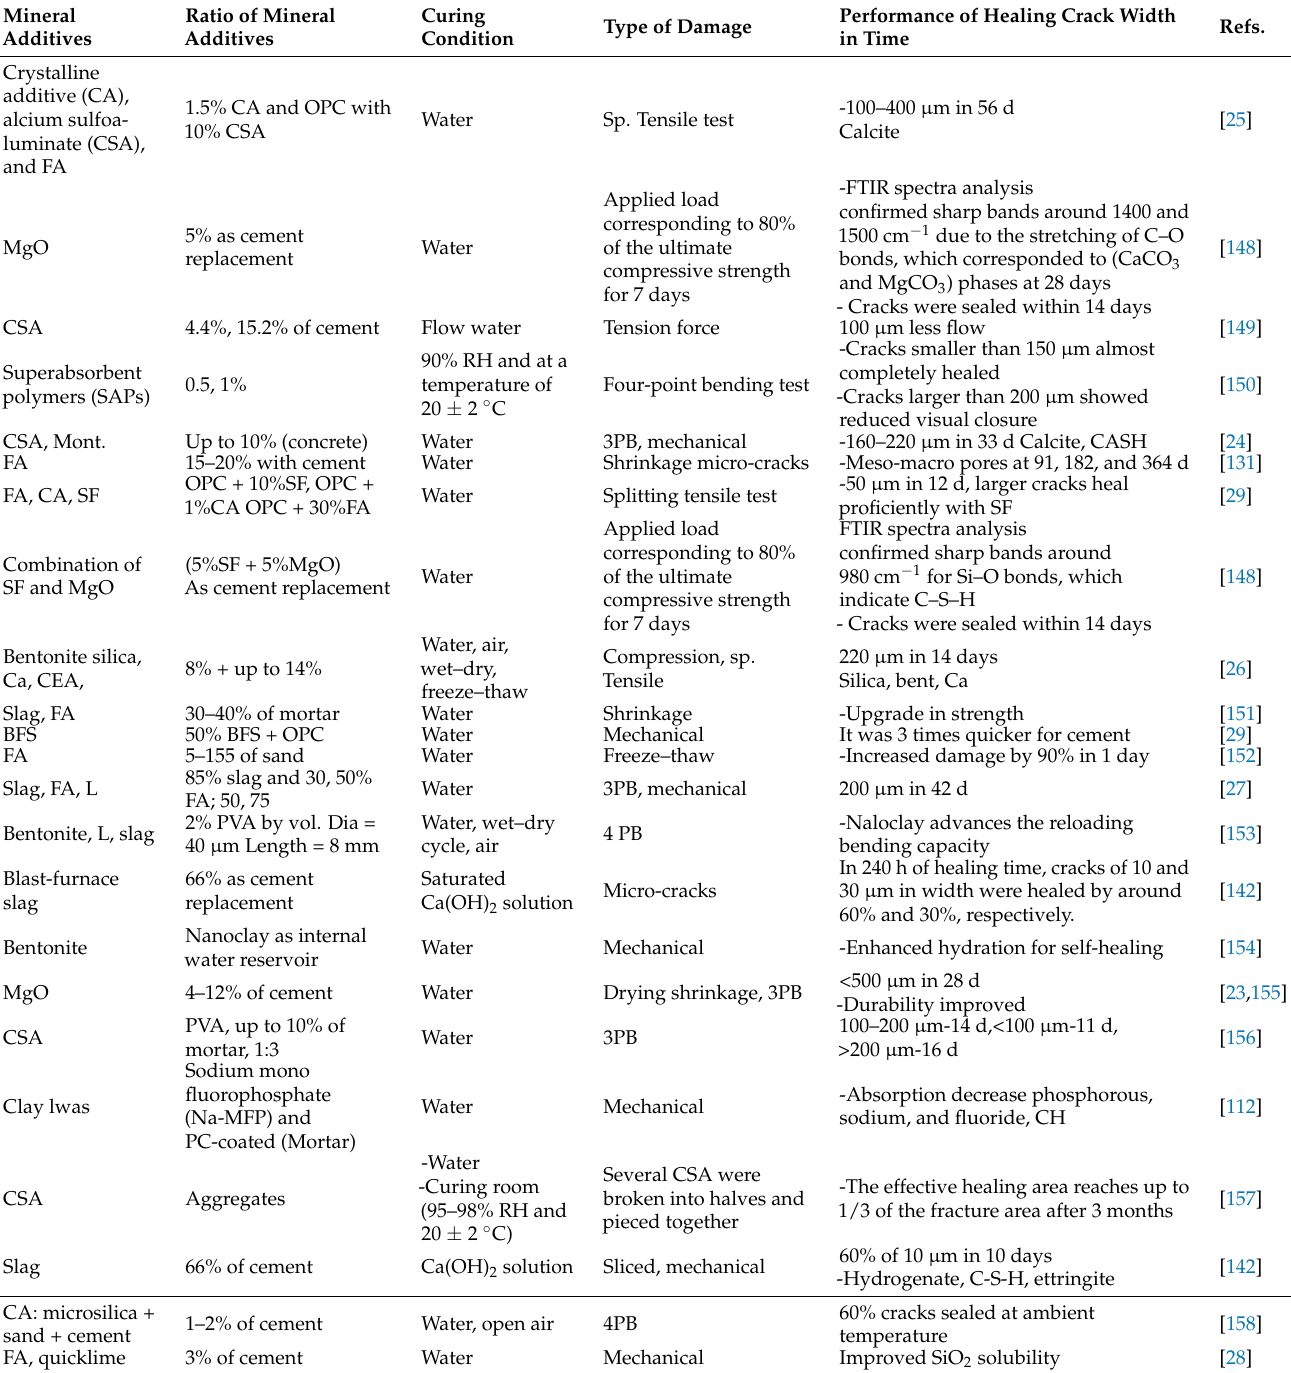
Table 3. Development in autogenous self-healing of concretes with the addition of mineral additives.